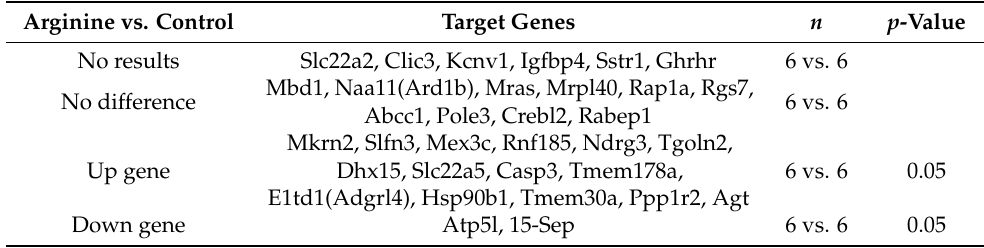
Table 5. Target gene RT-PCR results of differently expressed